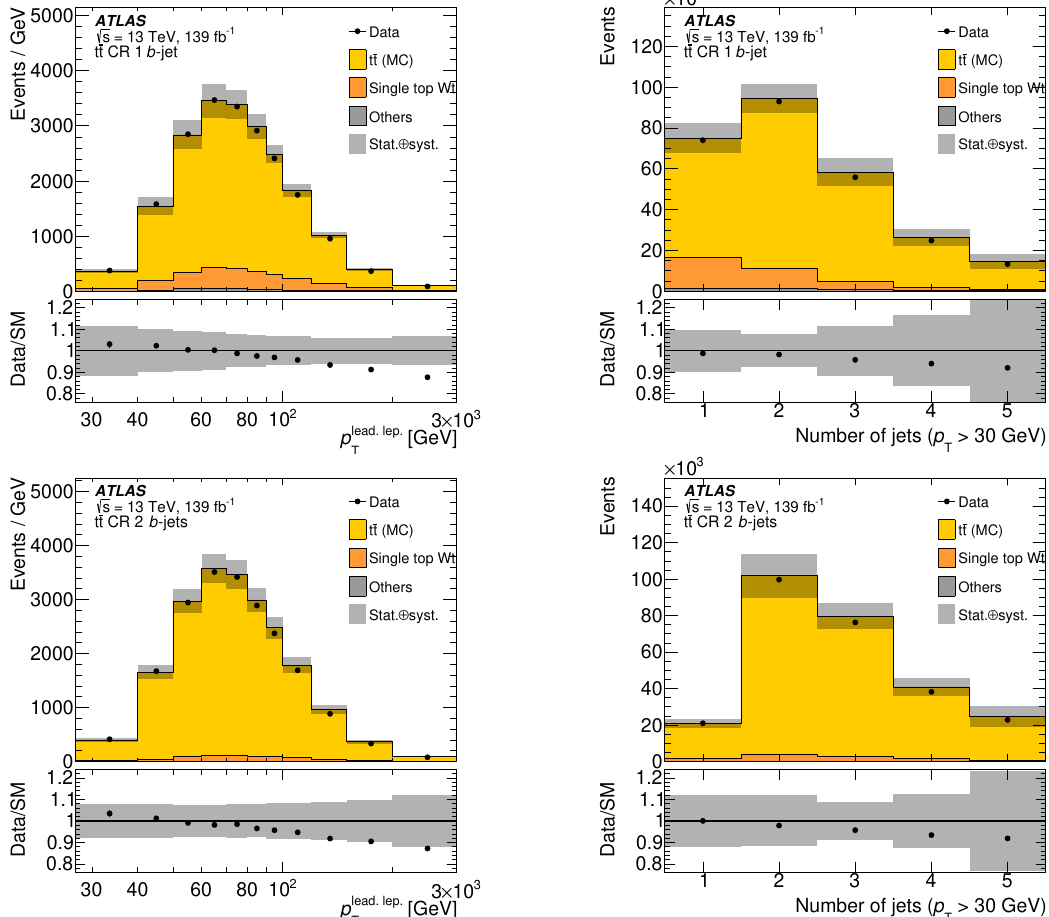
(left) and the jet multiplicity (right) in Figure 12 . Detector-level distributions of the p lead. lep. T the t ¯ t control regions with one b -jet (left) and two b -jets (right). Data are shown together with the predictions for t ¯ t , single-top Wt and other production processes from simulation. The last bin contains overflow events. The lower panels show the ratio of the data to the total prediction. The uncertainties shown include statistical and systematic